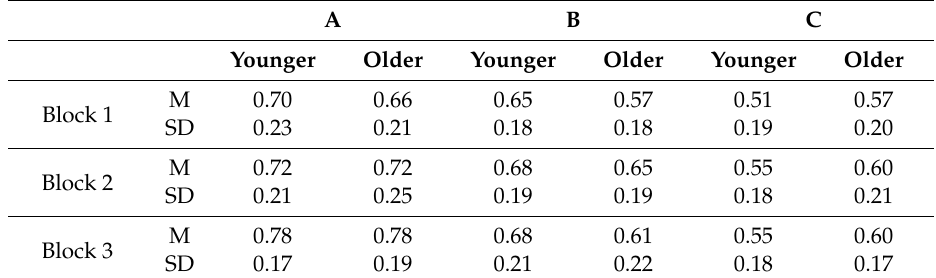
A B C Younger Older Younger